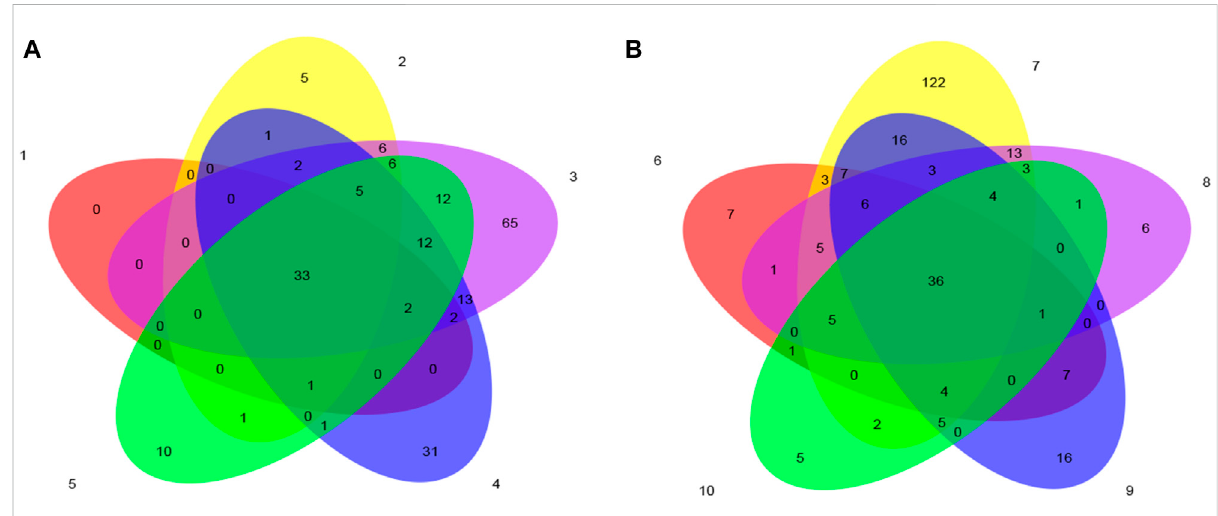
FIGURE 5 Venn diagram based on OTU of microbial community in cigar tobacco leaves. Note: (A) is the control group, and (B) is the test group.